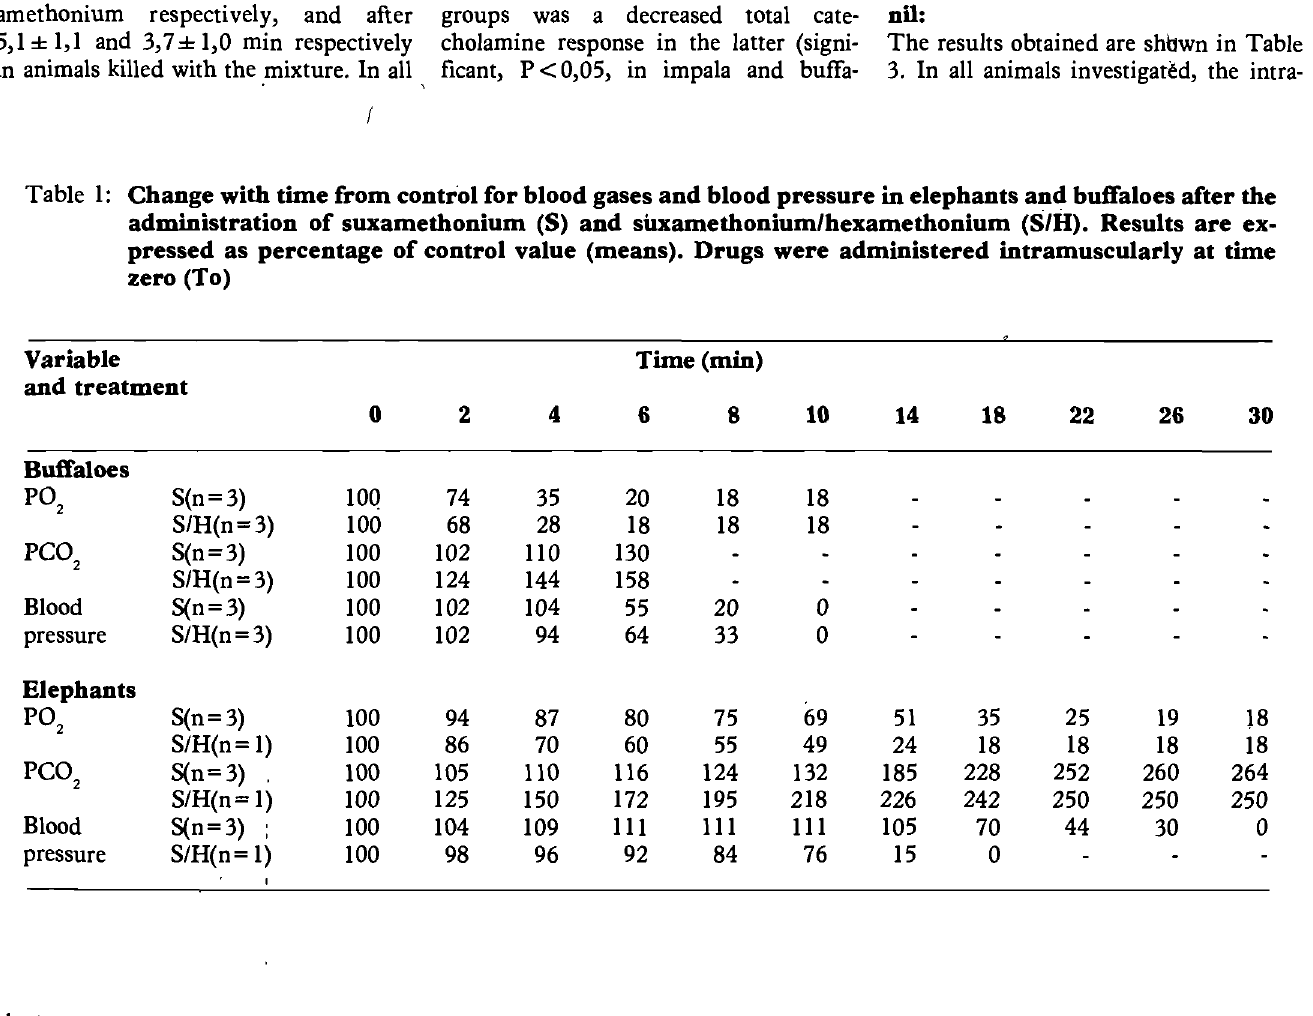
Table 1: Change with time from control for blood gases and blood pressure in elephants and buffaloes after the administration of suxamethonium (S) and suxamethonium/hexamethonium (SIB). Results are ex- pressed as percentage of control value (means). Drugs were administered intramuscularly at time zero